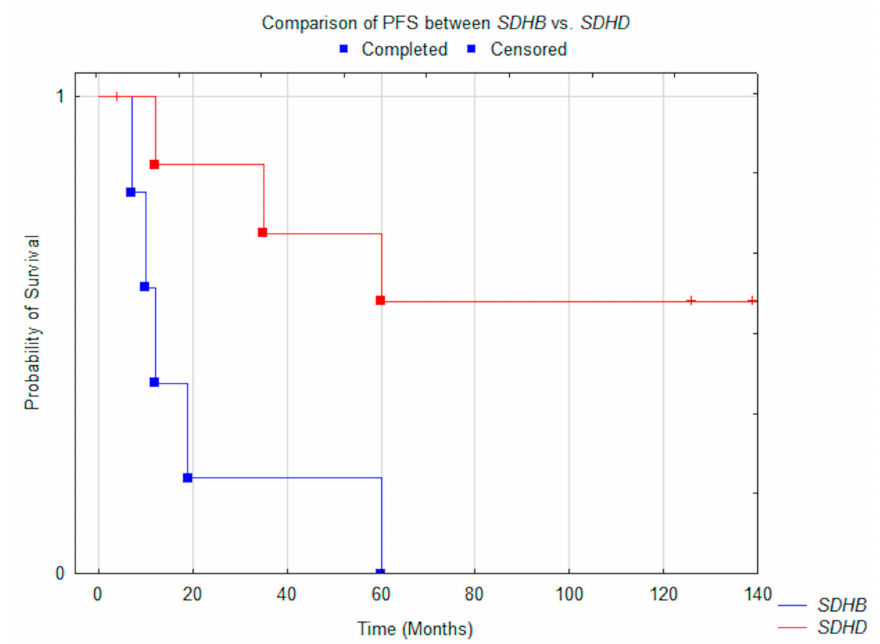
Figure 3. Comparison of median PFS between SDHD ( n = 8) vs. SDHB ( n = 5) patients ( p = 0.014).